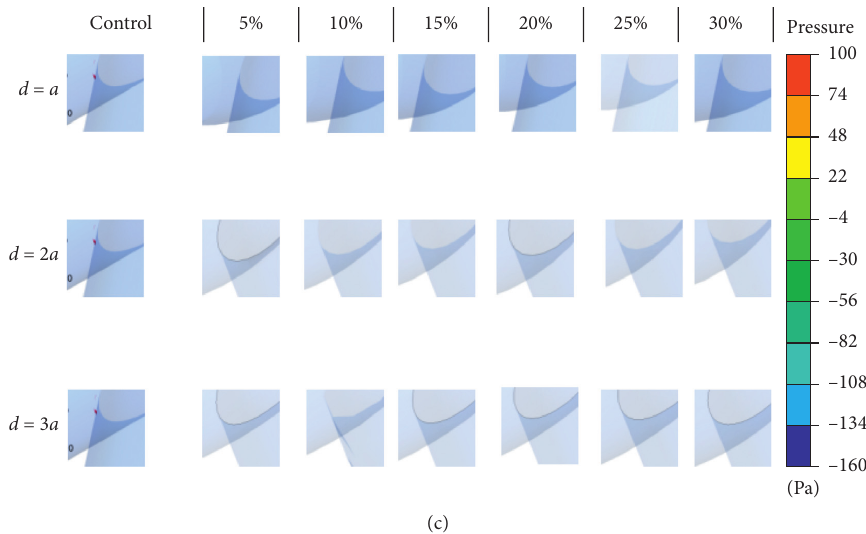
Figure 3: Pressure distribution. (a) Pressure distribution on the entire vessel. (b) Larger image of pressure distribution at the side branches and main walls. (c) Larger image of pressure distribution at the isosurface of pressure equals to